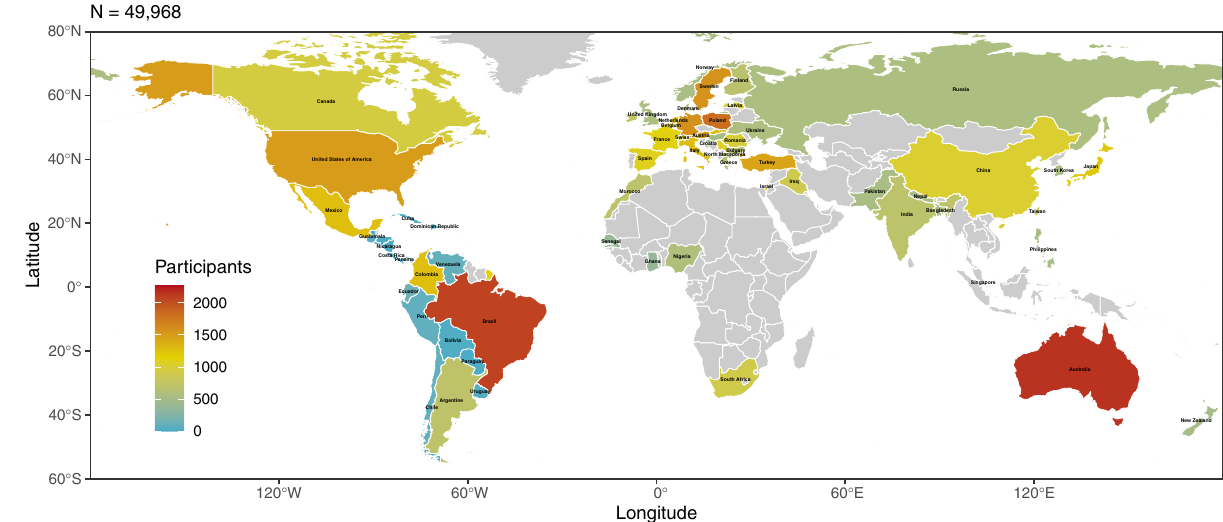
Fig. 1 Map of the 67 participating countries and territories with total sample size scaled to colour (we did not obtain samples from countries in grey). All the worldmaps were produced using R packages. The map is from the package ‘ rworldmap ’ and is licensed-free from South, A. (2011). rworldmap: A New R package for Mapping Global Data. The R Journal, 3, 35-43. Table 1 Summary statistics and multi-level correlations for person-level measures. Variance Correlations Between Within